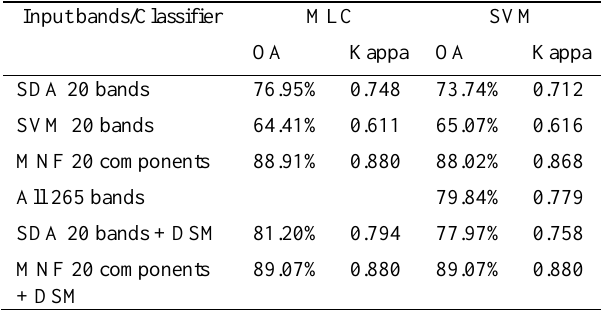
Table 2. Overall classification accuracy of different subsets